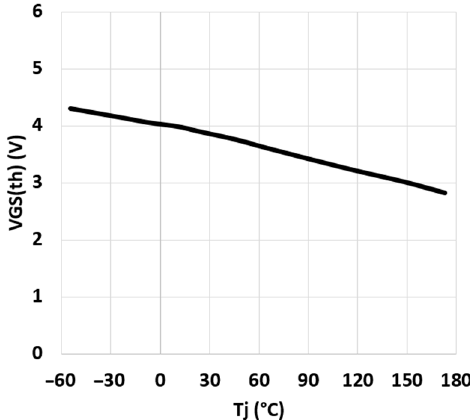
Figure 5. The threshold voltage of GaN HEMT cascode (NEXPERIA − GAN041650WSB) [46].